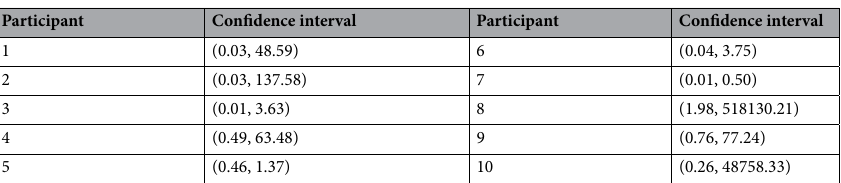
Table 1. Experimental results for Jarzynski’s equality. We include the confidence intervals for the left hand side of (5), which we obtain after bootstrapping the observed values of � E ext ( x ) for the forward process 1000 times X ) � and estimating � e − β� E ext ( by its mean for each set of bootstrapped data. In our experiment we have (cid:31) F = 0 X ) � = 1.0 in the right hand side of (5), resulting in a theoretical prediction of � e − β� E ext ( . Note, that for most subjects the value of 1.0 lies inside the confidence interval, which does not hold when assuming unsuitable loss functions, as discussed at the end of the Results. Participants that achieve at least 50% adaptation (c.f. Fig. 3) are shaded by a green background color